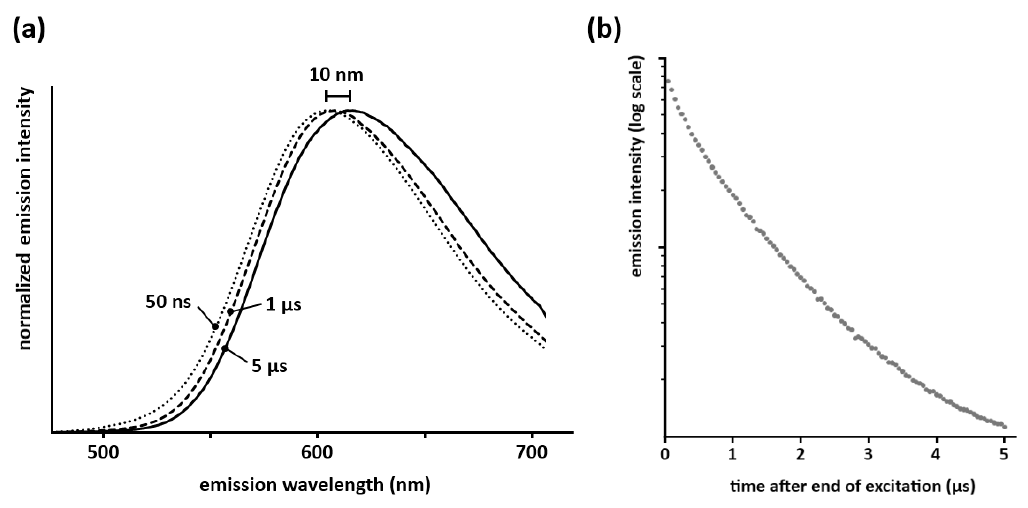
Si N :Eu during the first 2 5 8 = 337 exc